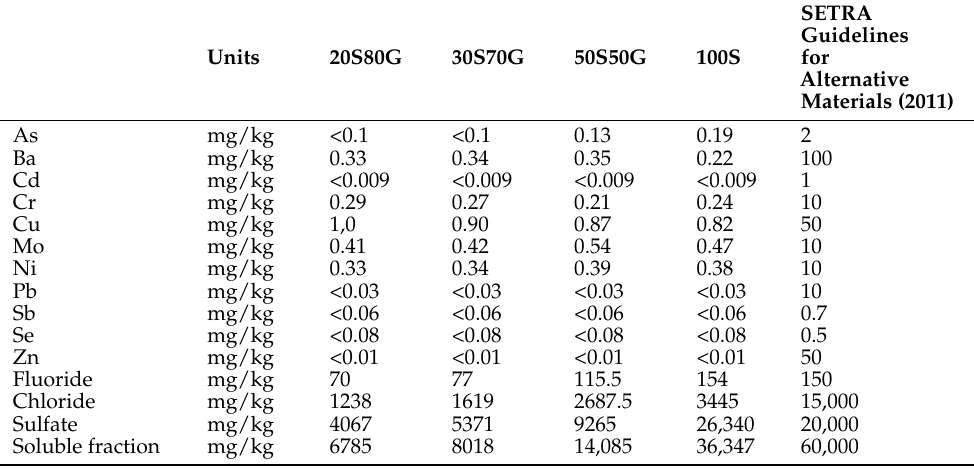
Table 7. Results of leaching test of